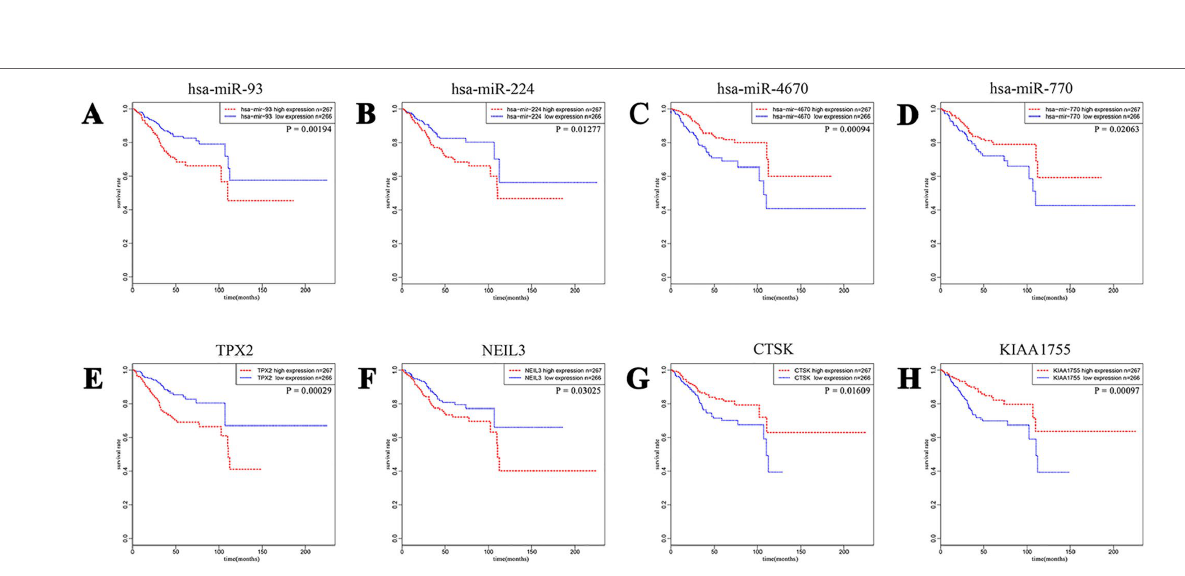
FIGURE 2 | A total of 320 out of 4,613 DE mRNAs and 68 out of 531 DE miRNAs associated with a poorer survival rate were chosen. The eight plots show Kaplan–Meier curves of the partial DE miRNAs and DE mRNAs between cases of high-expression group and low-expression group divided according to the median expression level. (A and B) Upregulated miRNA-93 and miRNA-224. (C and D) Downregulated miRNA-4670 and miRNA-770. (E and F) Upregulated TPX2 and NEIL3. (G and H) Downregulated CTSK and KIAA1755.